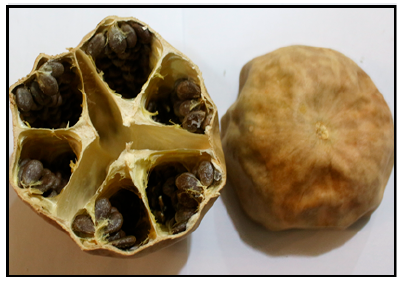
Figure 1. Photograph of fruits of C. colocynthis.